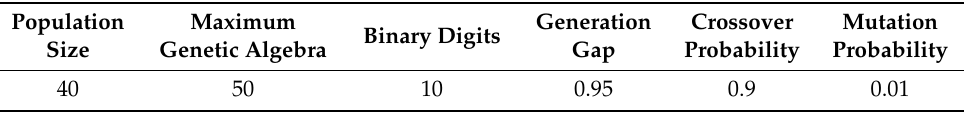
Table 4. Parameters of the genetic algorithm.